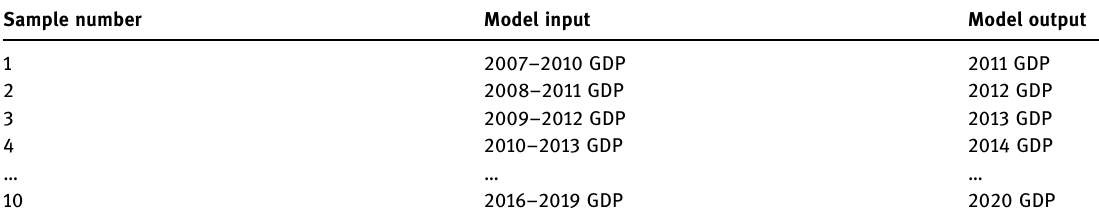
Table 2: Validation